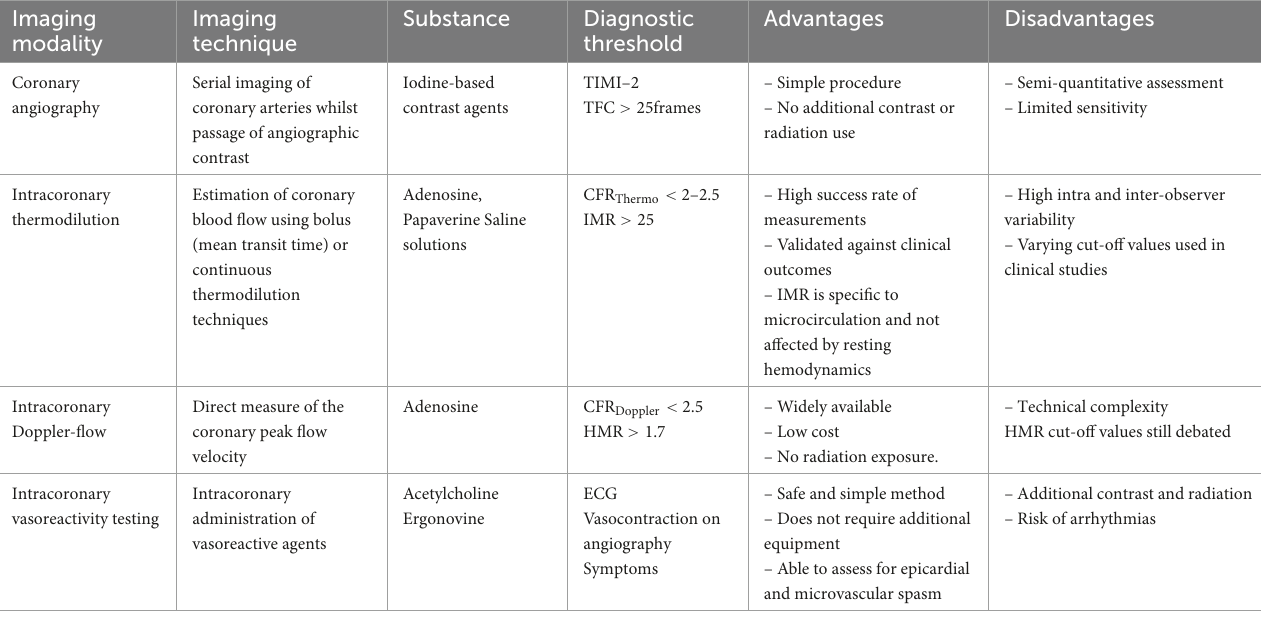
TABLE 2 Invasive diagnostic modalities for evaluation of the coronary